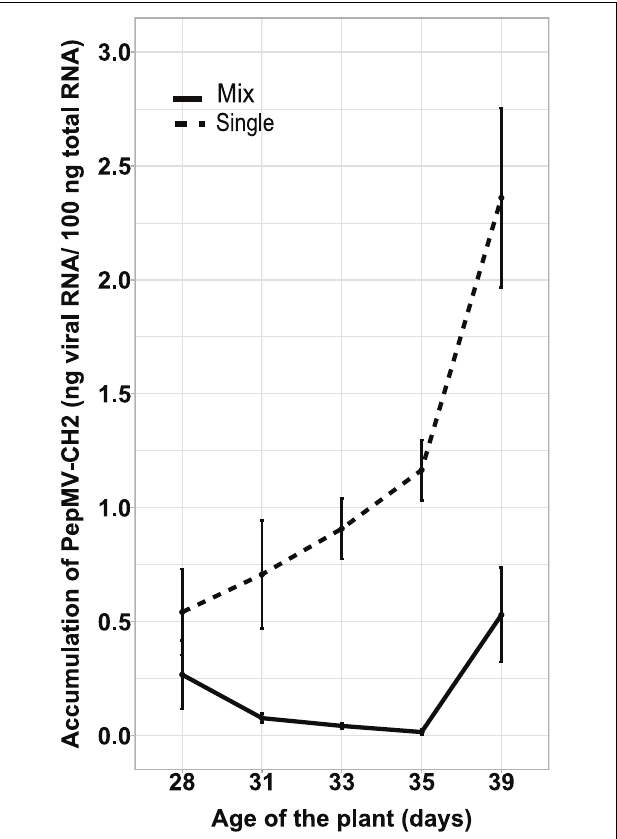
FIGURE 1 | Effect of the plants’ age on the PepMV-EU antagonism over PepMV-CH2 in mixed infections. PepMV-CH2 accumulation was measured in single and mixed PepMV-CH2 + PepMV-EU infections in plants inoculated at different ages. Accumulation was measured by absolute RT-qPCR and shown as ng viral RNA/100 ng total RNA from three plants at 28, 31, 33, 35, and 39 days post germination in single (continuous line) and mixed infected (dashed line)